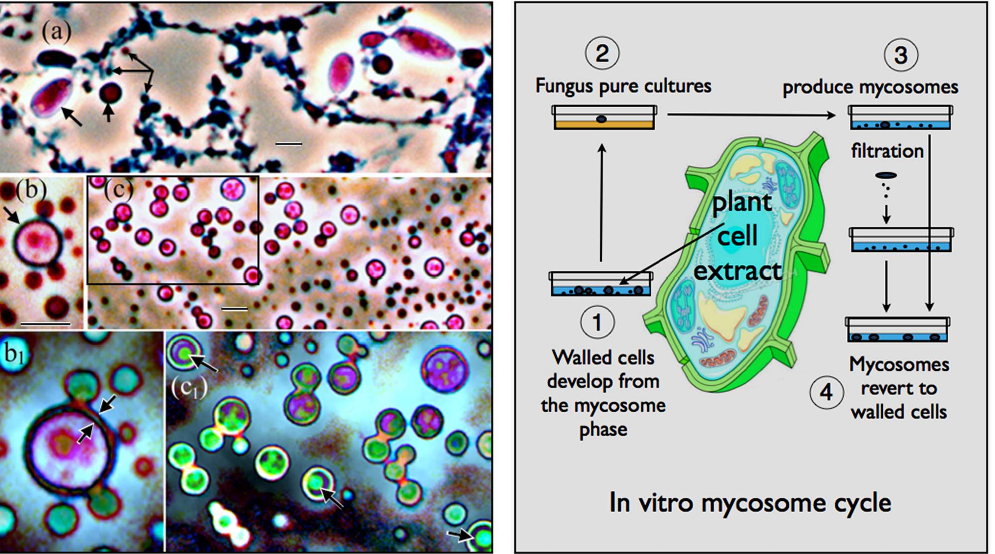
Figure 1. In vitro mycosome-phase culture. (a) Protoplast filaments from Psilotum nudum cell extract contain condensed-Ms (3 small arrows) that enlarge as spheroid protoplasts (short arrow) and Aureobasidium pullulans conidia (long arrow). (b and c) A. pullulans hyphae cultured 14 months in distilled water + erythromycin (Ms longevity test) produced condensed-Ms that divide symmetrically or by budding, and enlarge as spheroid forms that express a central vacuole. (b 1 ) and (c 1 ) are enlargements of (b) and the boxed area of (c); the enlargements are artificially colored with a Photoshop filter sensitive to differences in stain density. The Ms-boundary, otherwise seen as an AB-staining wall-like structure (b, arrow), is actually a narrow protoplast bounded by vacuole and plasmalemma membranes (b 1 , arrows). A walled cell potentially develops within the central vacuole-like organelle (c 1 , arrows). Bars =2.0 m m. Right: In vitro mycosome cycle. (1) Cultured in liquid media, cell extract from macerated plant tissue yields walled fungus cells that develop from the mycosome (Ms) phase. (2) Fungus pure cultures are isolated on nutrient agar. (3) Induced in liquid media, fungus cells produce Ms. (4) Ms separated from parent cells (filtered 0.8 m m) are capable of reverting to walled cells.